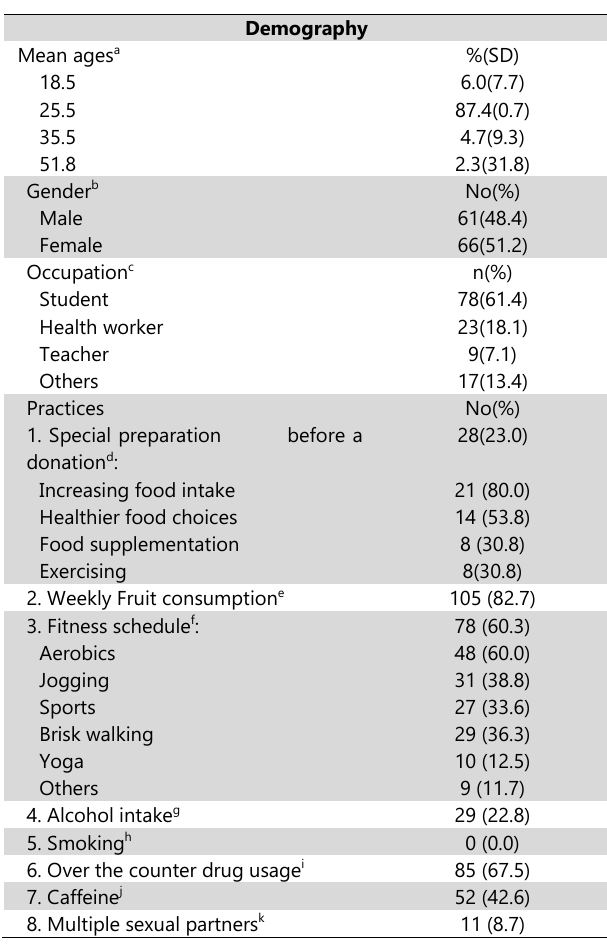
Table 1 . Summarises the Demography and Various Practices